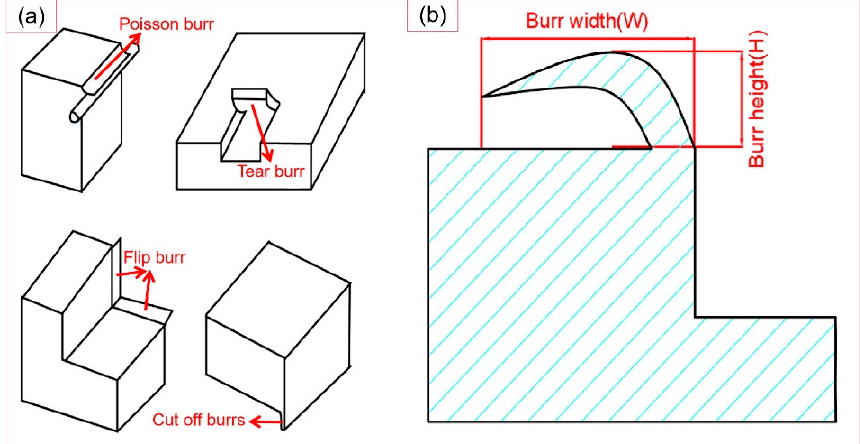
Figure 9. ( a ): Burr types; ( b ): burr size.